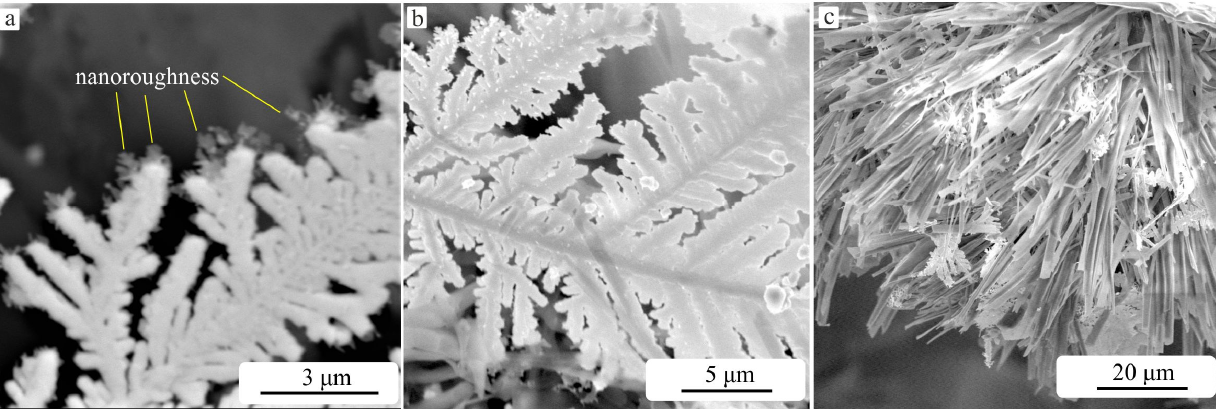
Figure 4. High magnification SEM images of the two different morphologies developed on the superhydrophobic copper foam. ( a , b ) for the silver and ( c ) for the copper